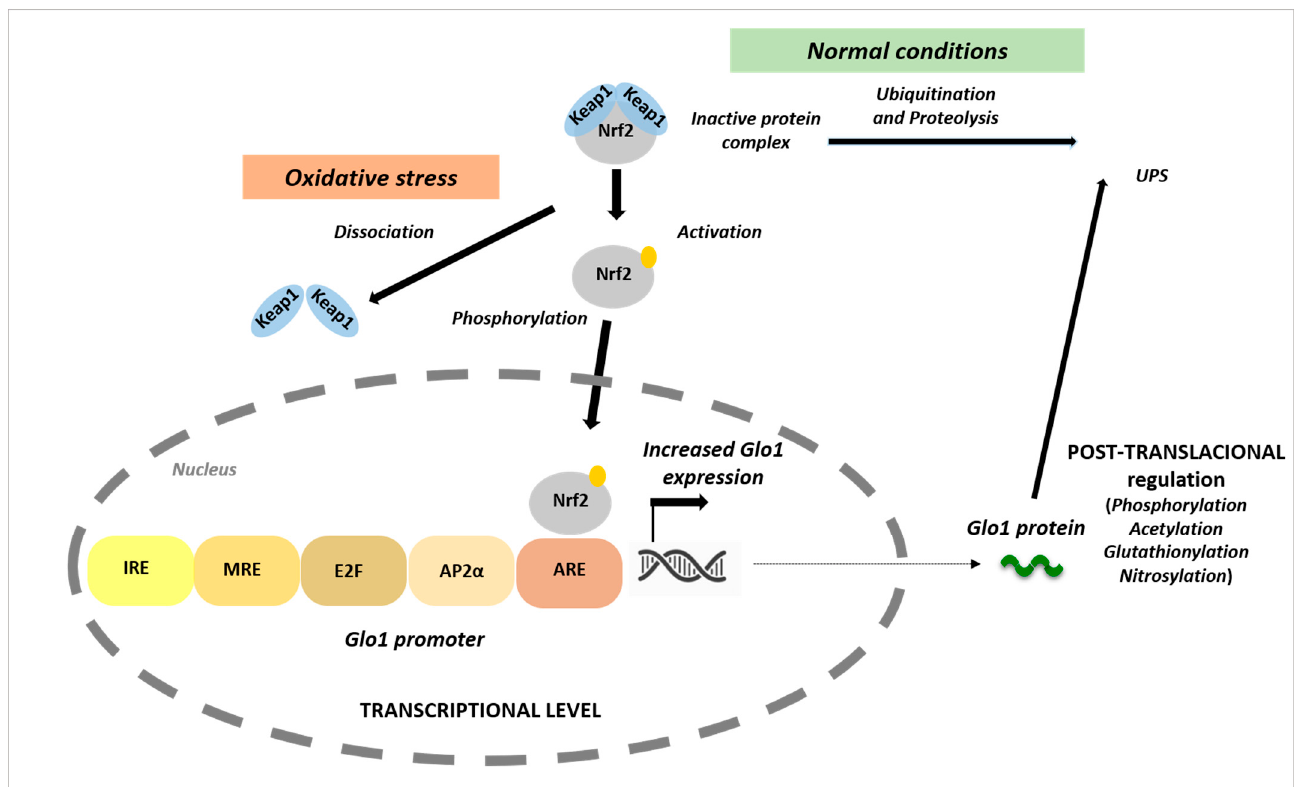
Figure 2. Mechanisms of glyoxalase 1 (GLO1) regulation. GLO1 activity can be regulated through multiple mechanisms, including transcriptional regulation and post-translational modifications. The Glo1 promoter contains various regulatory elements, such as antioxidant response (ARE), metal-response (MRE) and insulin-response (IRE) elements, and binding sites for AP-2 α and E2F. In normal conditions, the nuclear factor erythroid 2-related factor 2 (NRF2) is complexed with KEAP1, a substrate adaptor protein for cullin-3-dependent E2 ubiquitin lipase complex, directing NRF2 for degradation by the ubiquitin proteasome system (UPS). Oxidative stress leads to the destabilization of the complex NRF2-KEAP1, causes the detachment of NRF2 that is translocated to the nucleus where triggers the upregulation of different antioxidants genes. Binding of NRF2 to the Glo1- ARE increases expression of GLO1. Under hypoxia conditions Glo1 expression is inversely regulated by hypoxia-inducible factor 1 α (HIF1 α ). Different post-translational modifications in the cytosol can impact GLO1 stability.